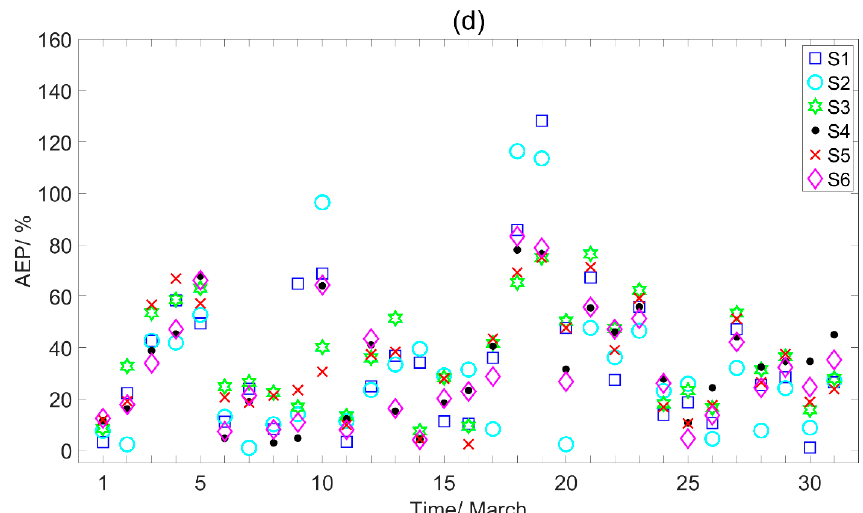
Figure 9. Distributions of daily AEPs for di ff erent parameterization schemes. ( a , b ) are the results of 30 m, ( c , d ) are the results of 60 m. ( a , c ) are the simulation results with the GFS as the initial data; ( b , d ) are the simulation results with the ERA5 as the initial data. Table 7. Average AEPs for di ff erent combinations of initial data and parameterization schemes.